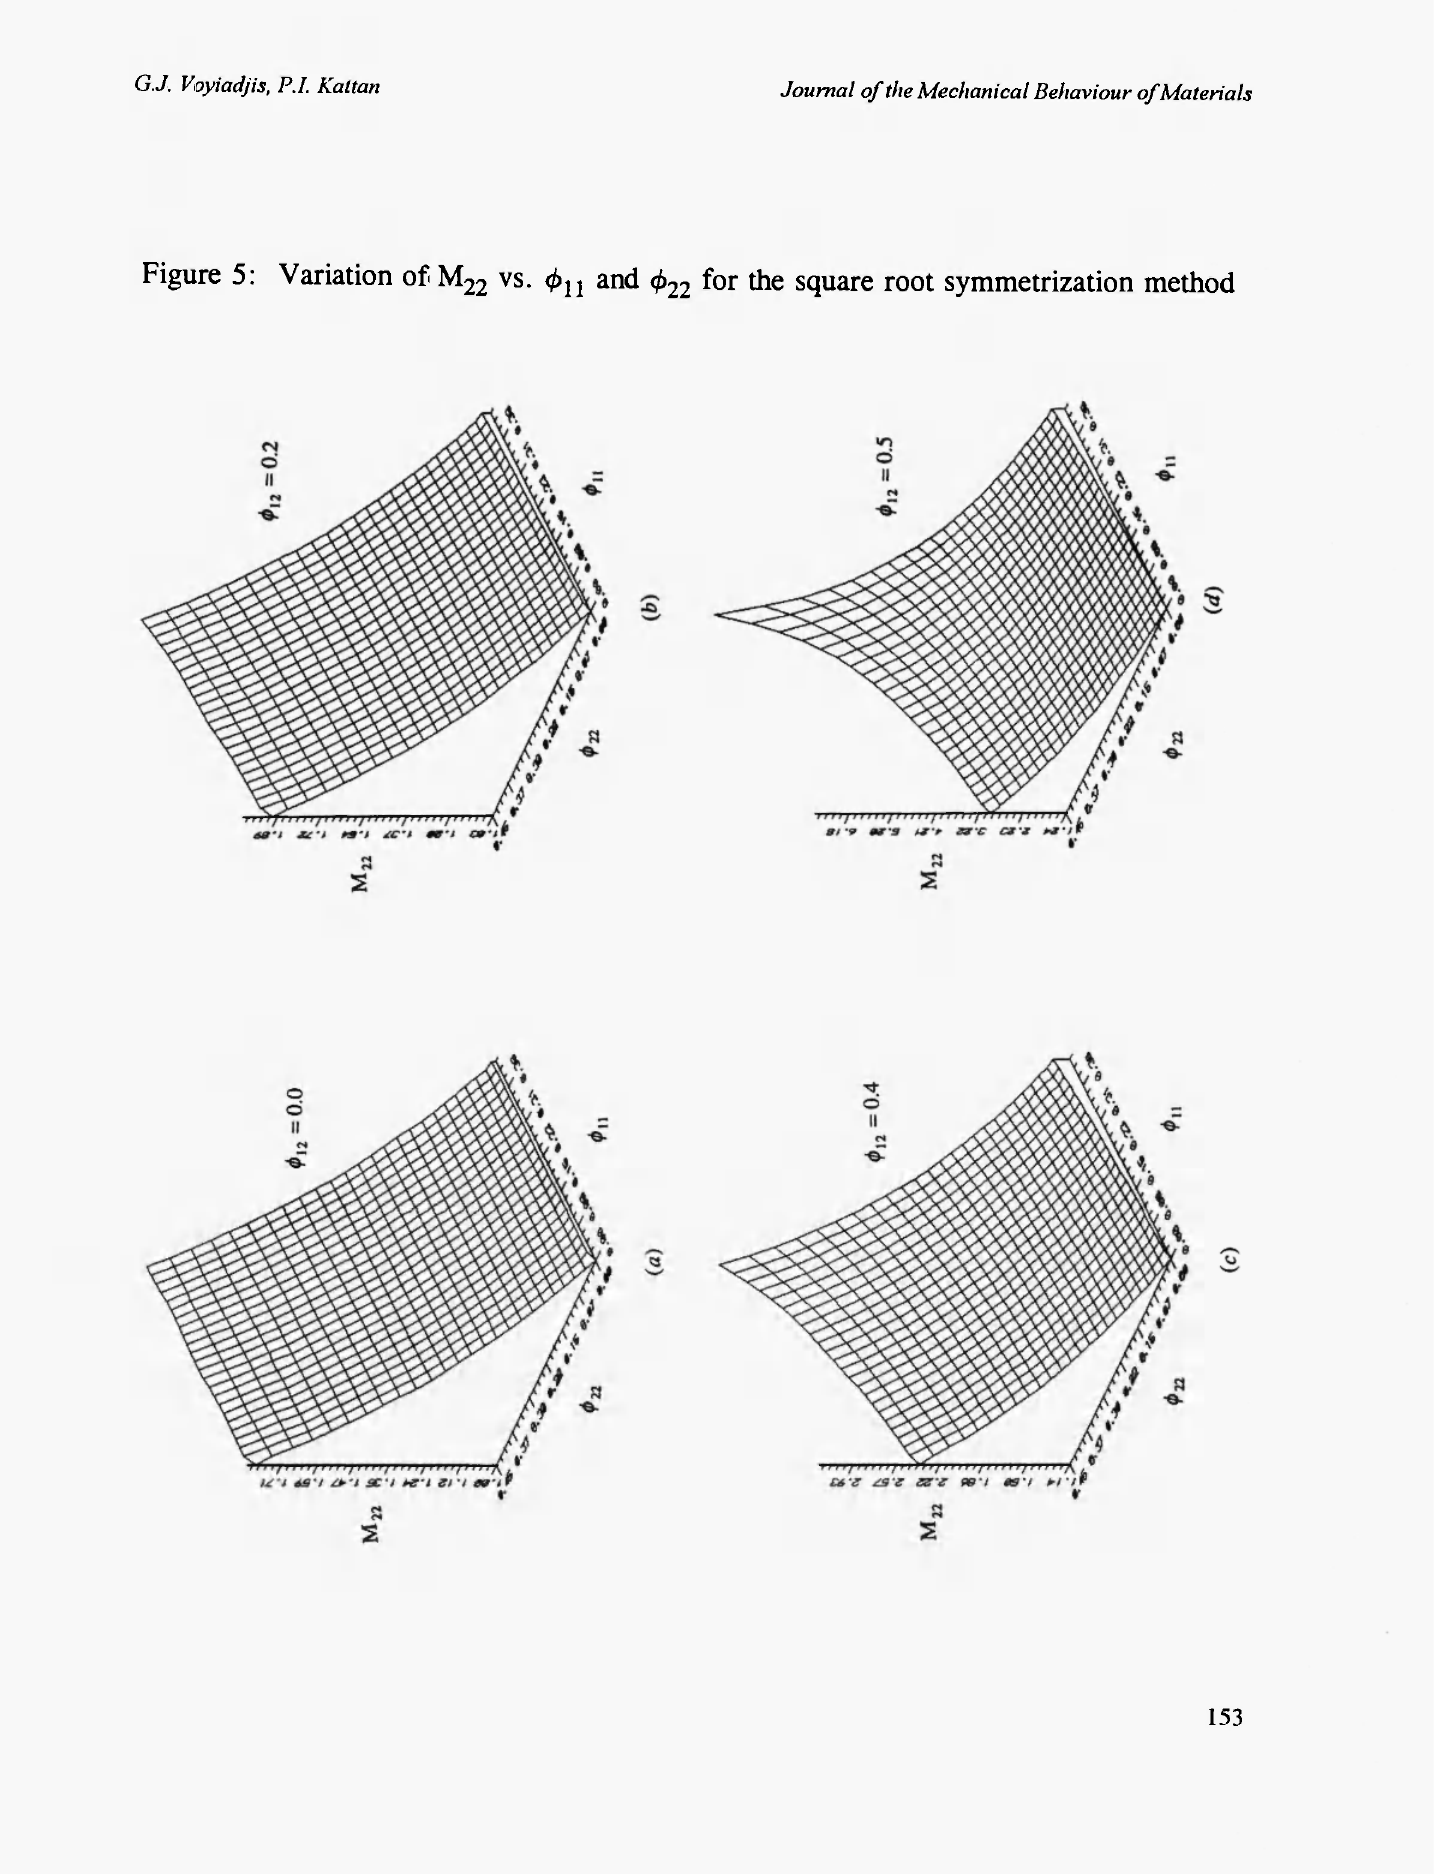
Figure 5: Variation of M